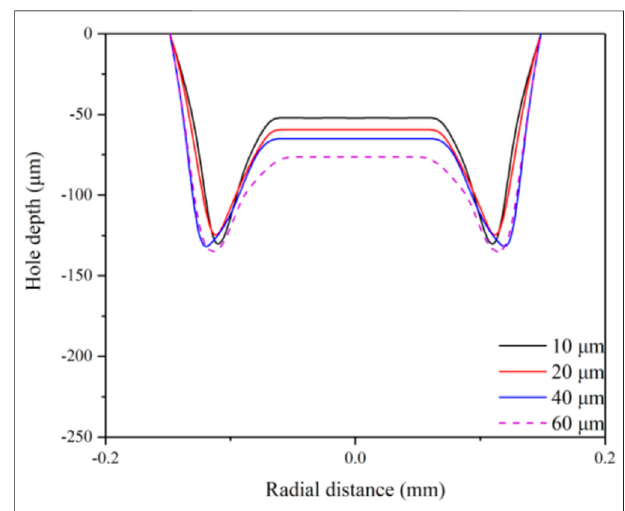
FIGURE 15 | Comparison of cross-section pro fi les with respect to different vibrational frequencies.